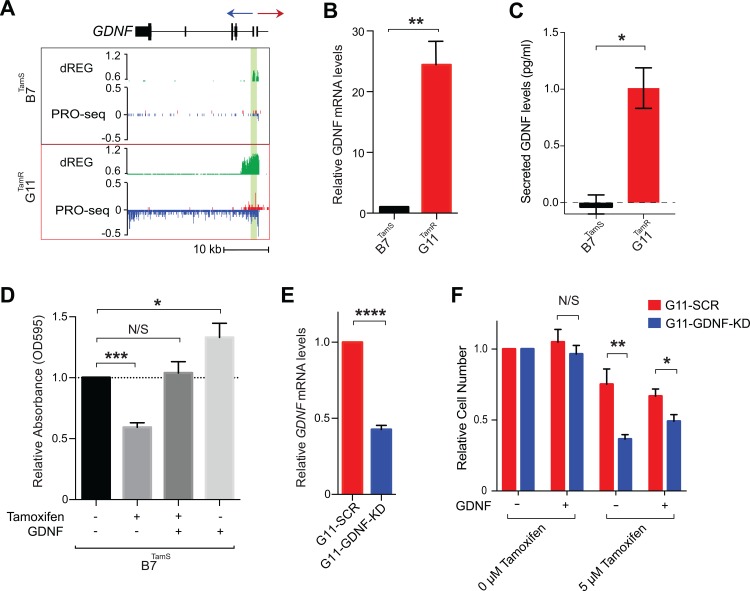
GDNF is responsible for tamoxifen resistance in MCF-7 cells.(a) Transcription near the GDNF locus in B7TamS and G11TamR cells. PRO-seq densities on sense strand and anti-sense strand are shown in red and blue, respectively. dREG scores are shown in green. The region near the GDNF promoter is shown in light green shading. Arrow indicates the direction of gene annotations. (b) GDNF mRNA expression levels in B7TamS and G11TamR cells. Data are represented as mean ± SEM (n = 3). ** p < 0.005. (c) Secreted GDNF levels in B7TamS and G11TamR cells. Data are represented as mean ± SEM (n = 2). * p < 0.05. (d) Cell viability of B7TamS cells in the presence or absence of 10 ng/ml GDNF and/or 100 mM tamoxifen for 4 days. Data are represented as mean ± SEM (n = 3). * p < 0.05, *** p < 0.0005. (e) GDNF mRNA expression levels in G11TamR scrambled (SCR) and G11TamR GDNF knockdown (GDNF-KD) cells. Data are represented as mean ± SEM (n = 3). **** p < 0.0001. (f) Relative cell number of G11TamR scrambled (SCR) and G11TamR GDNF knockdown (GDNF-KD) cells after 4 days without or with 5 μM tamoxifen and/or 5 ng/ml GDNF treatment. Data are represented as mean ± SEM (n = 9). * p < 0.05, ** p < 0.005.